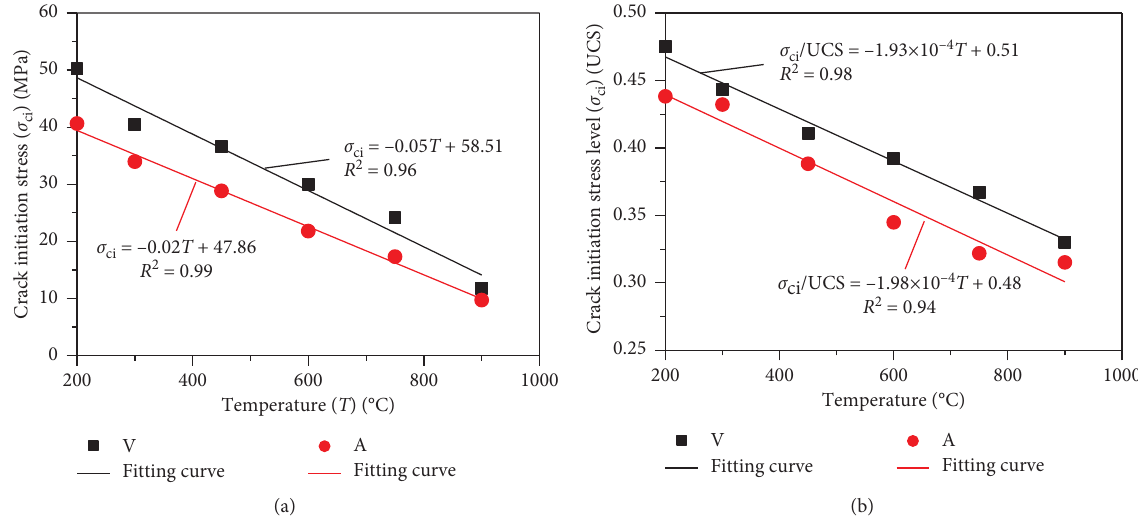
Figure 10: Variations in (a) crack initiation stress and (b) crack initiation stress level with different